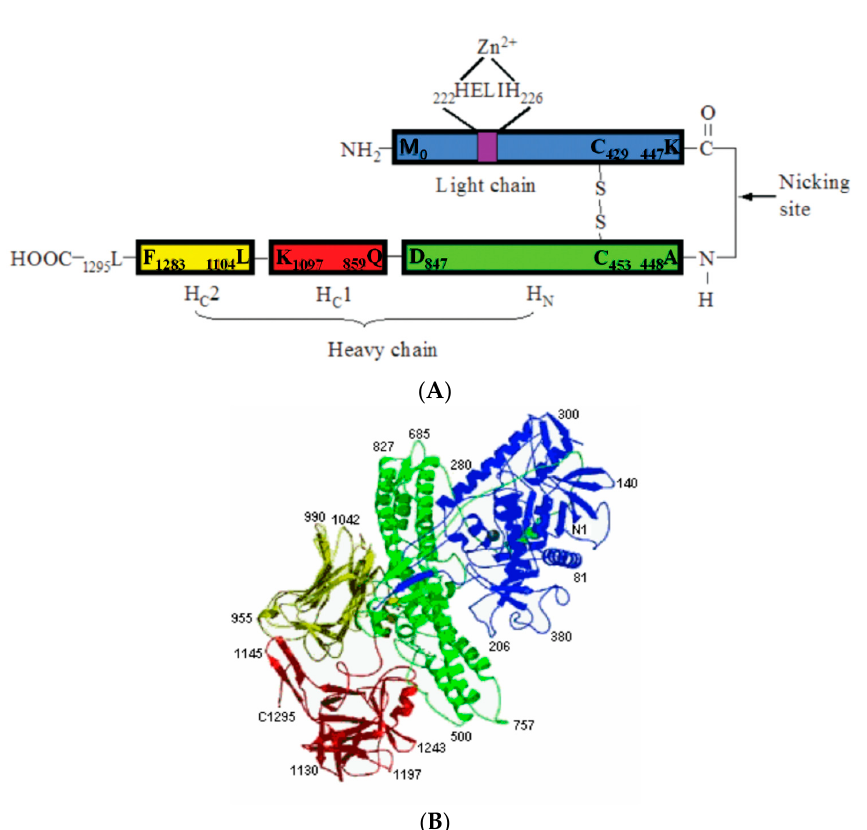
Figure 2. ( A ) Schematic diagram of a BoNT (BoNT/A) showing different domains. ( B ) Three- dimensional representation of the backbone BoNT/A [66]. The catalytic domain LC is indicated in blue, the translocation domain HN is in green, and the receptor-binding domain HCC and HCN are in yellow and red, respectively.